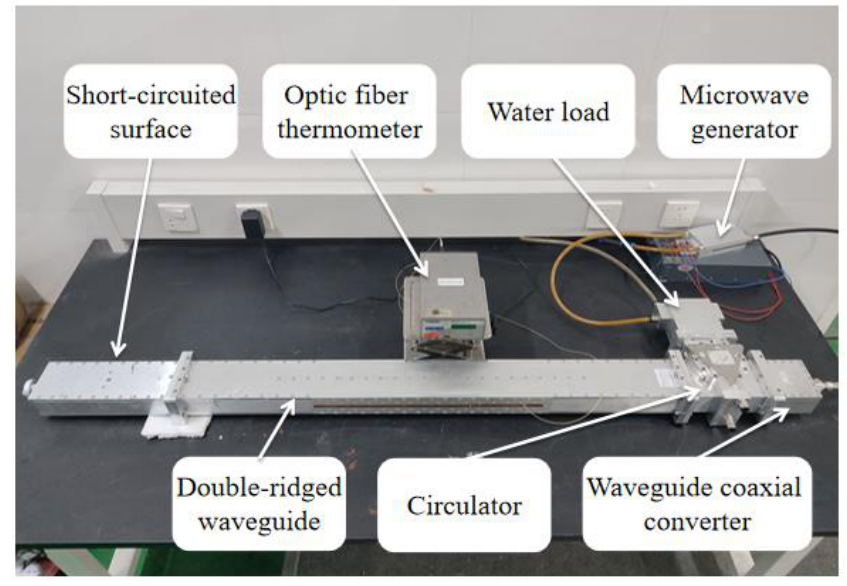
Figure 6. The photograph of the experimental system.